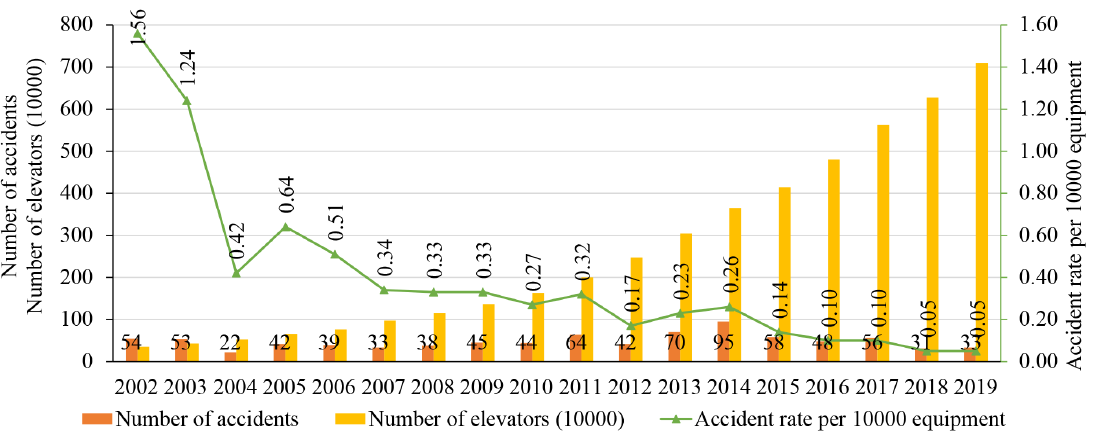
Fig. 1 Accidents and the existing quantity of elevators in China from 2002 to